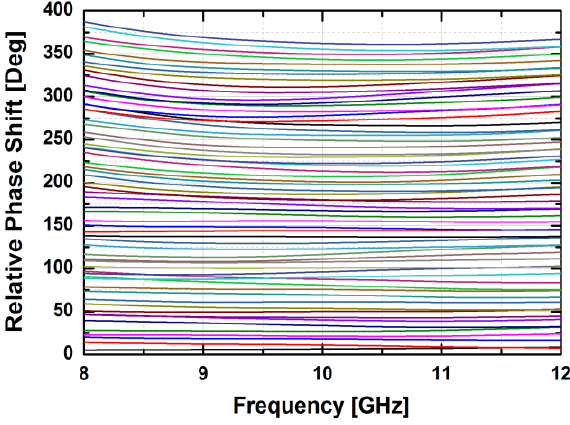
Figure 24. The relative phase shift levels of the fabricated TRM vs. the control bits over frequency.